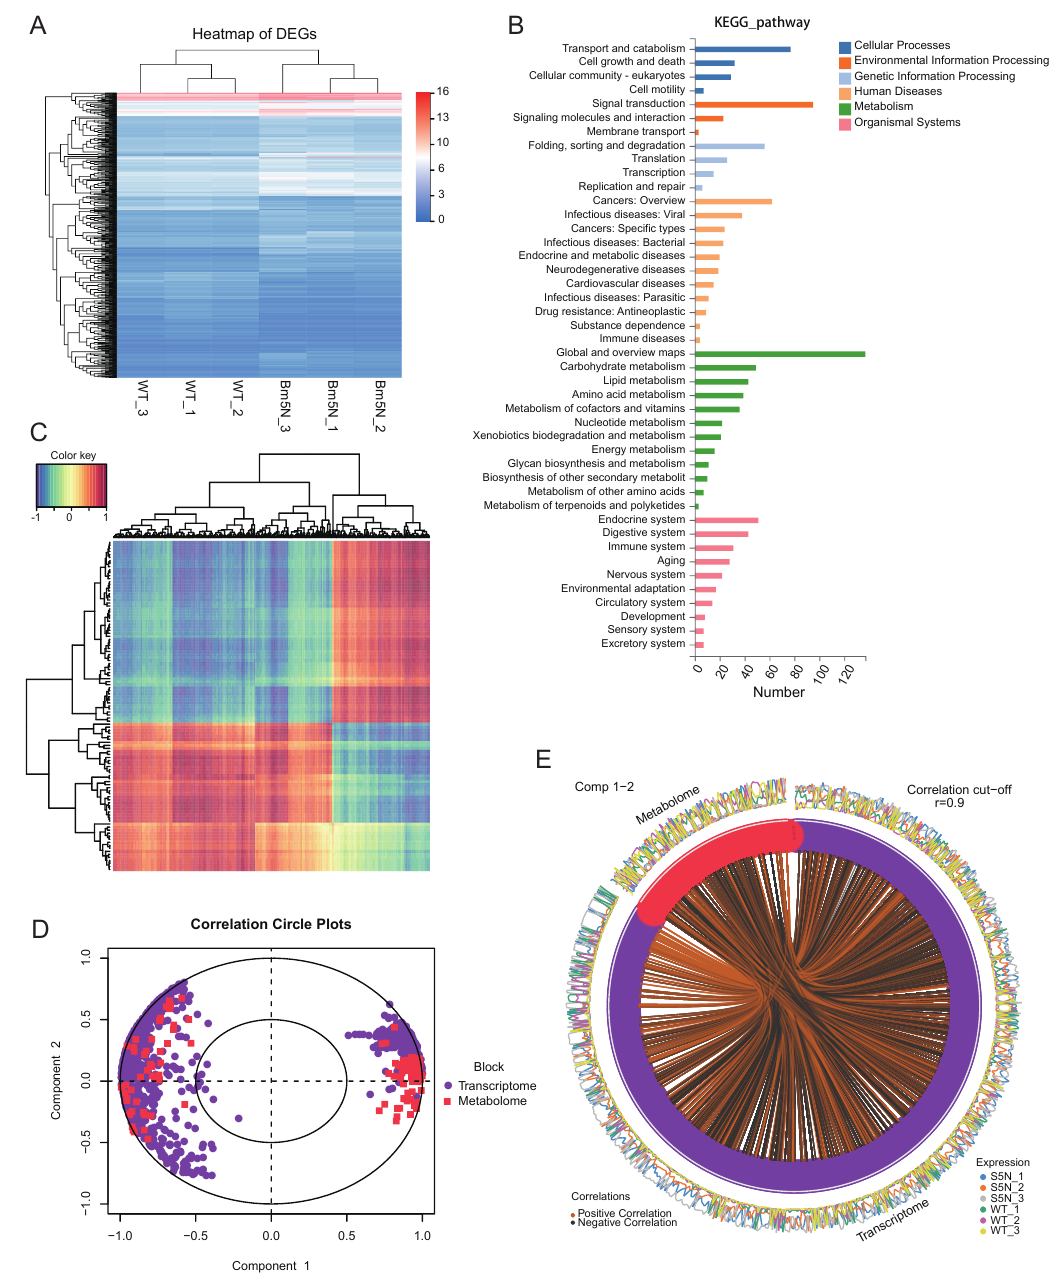
Figure 6. Bm5 (cid:48) N loss alters metabolome and transcriptome. ( A ) Heat map of differential gene expression detected in transcriptomics analysis. Statistical analysis (|fold change| ≥ 3 and p -value <0.05) identified 972 genes. ( B ) Column chart of the KEGG enrichment results of DEGs. ( C ) Correlation cluster heat map of metabolomics and transcriptomics. Each row represents a differentially produced metabolite and each column represents a differentially expressed gene. Red indicates positive correlation, whereas blue indicates negative correlation. ( D ) Concentric circle of differentially expressed genes and metabolites. The RCCA results were visualized using plotVar. Every dot represents one gene, each square represents a metabolite. An angle <90 ◦ indicates a positive correlation, >90 ◦ means a negative correlation. Taking the center of the circle as the starting point, the longer line length means a stronger relationship. The variables far away from the center of the circle have a strong correlation. ( E ) Circus analysis of differential genes and differential metabolites. The RCCA results were visualized using circosPlot. The line of circle represents the correlation coefficients were larger than 0.9 between differential genes and differential metabolites. Blue curves of peripheral regions represent the expression of differential metabolites. Orange curves of peripheral regions represent the expression of differential